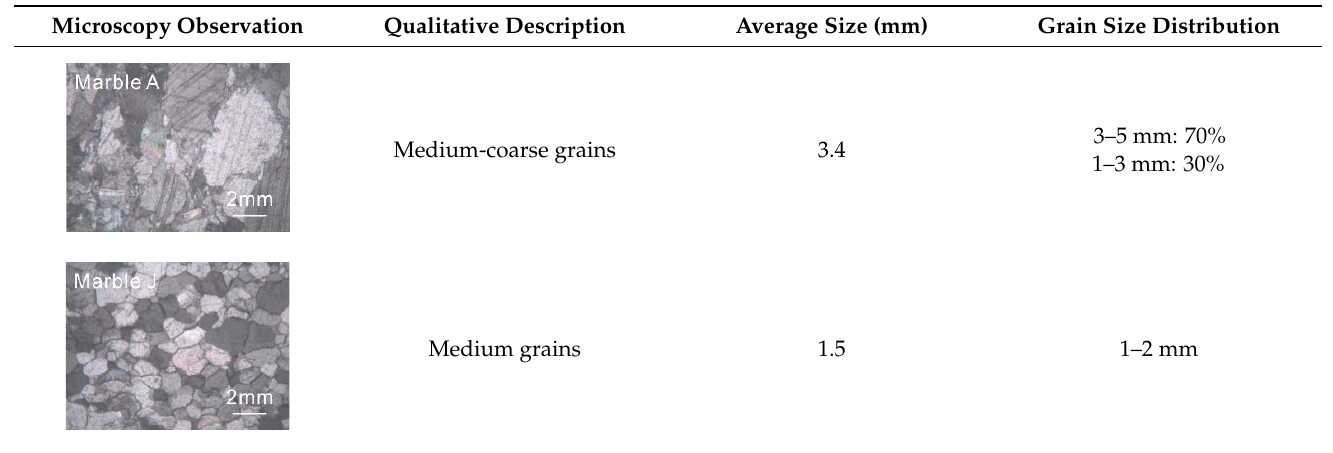
Table 1. Microstructures of the rock specimens.